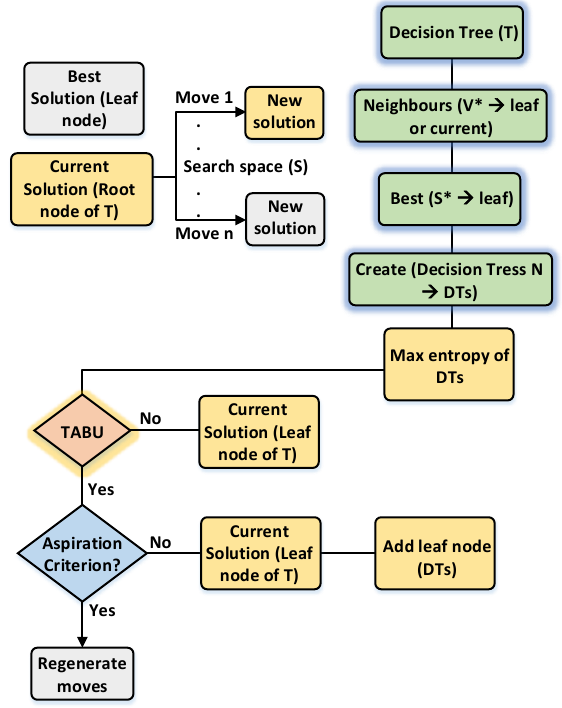
Figure 2. Data flow of the proposed TSODT